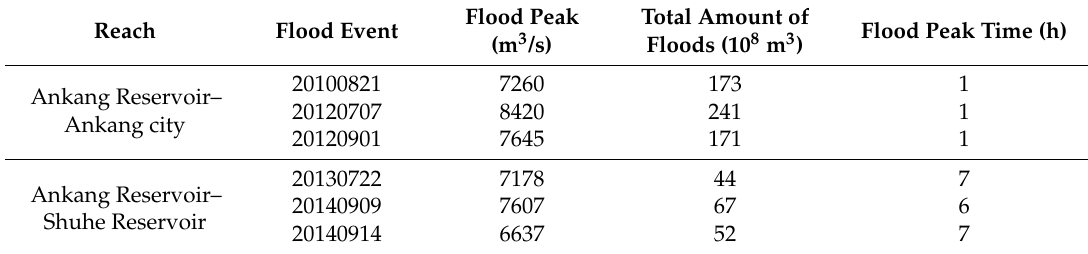
Table 2. Data of Table 2. Data of flood.